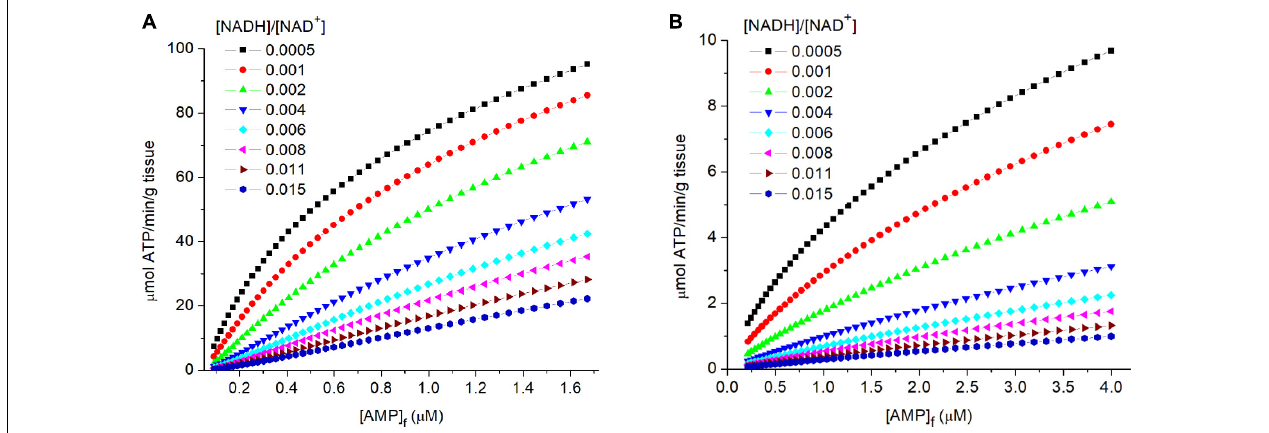
FIGURE 4 | (A,B) The relationship of flux through PK to the levels of free AMP ([AMP] f ) in tissue. In the simulations described in the legend of Figure 3 , the concentrations of free AMP were calculated assuming equilibration of adenylate kinase and an equilibrium constant of 1. The calculated flux through PK is plotted against [AMP] f (abscissa). The [AMP] f concentration for 50% activity of AMP dependent protein kinase (AMPK) in isolated perfused rat heart has been reported to be 1.8 µ M (Frederich and Balschi,